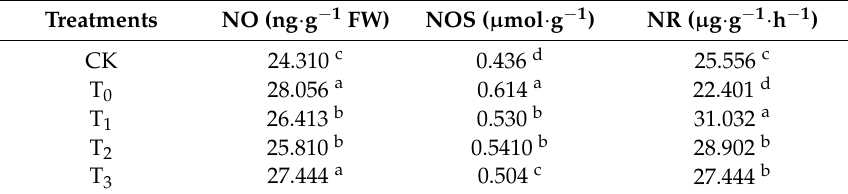
Table 2. Effect of the NO donor on NO, NOS, and NR content under enhanced UV-B radiation in Larix gmelinii seedlings.